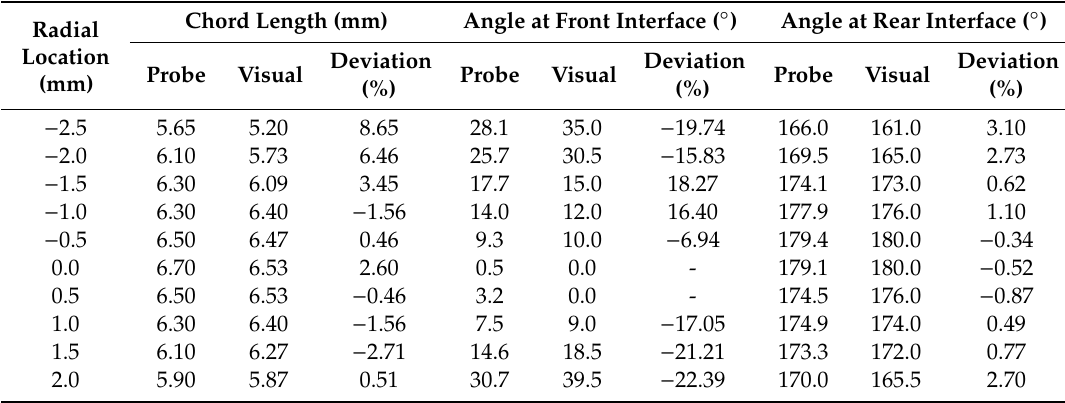
Table 3. Probe and visual measurement of bubble chord length and interface direction.